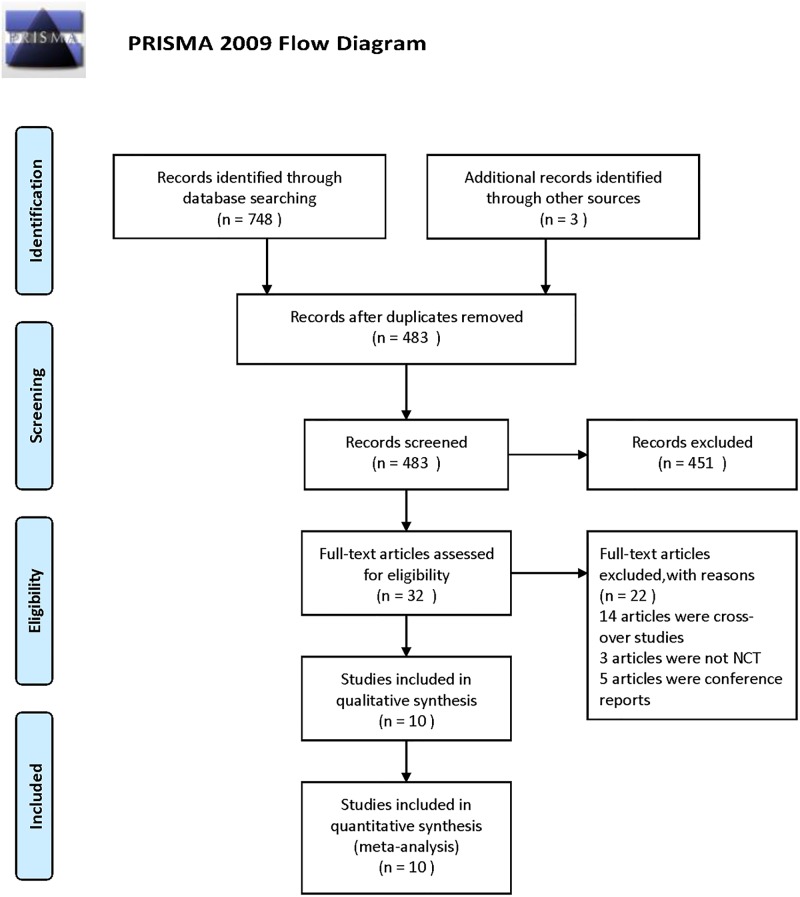
Flow diagram of papers screening.From: Moher D, Liberati A, Tetzlaff J, Altman DG, The PRISMA Group (2009). Preferred Reporting Items for Systematic Reviews and Meta-Analyses: The PRISMA Statement. PLoS Med 6(7): e1000097. doi: 10.1371/journal.pmed1000097
For more information, visit
www.prisma-statement.org.